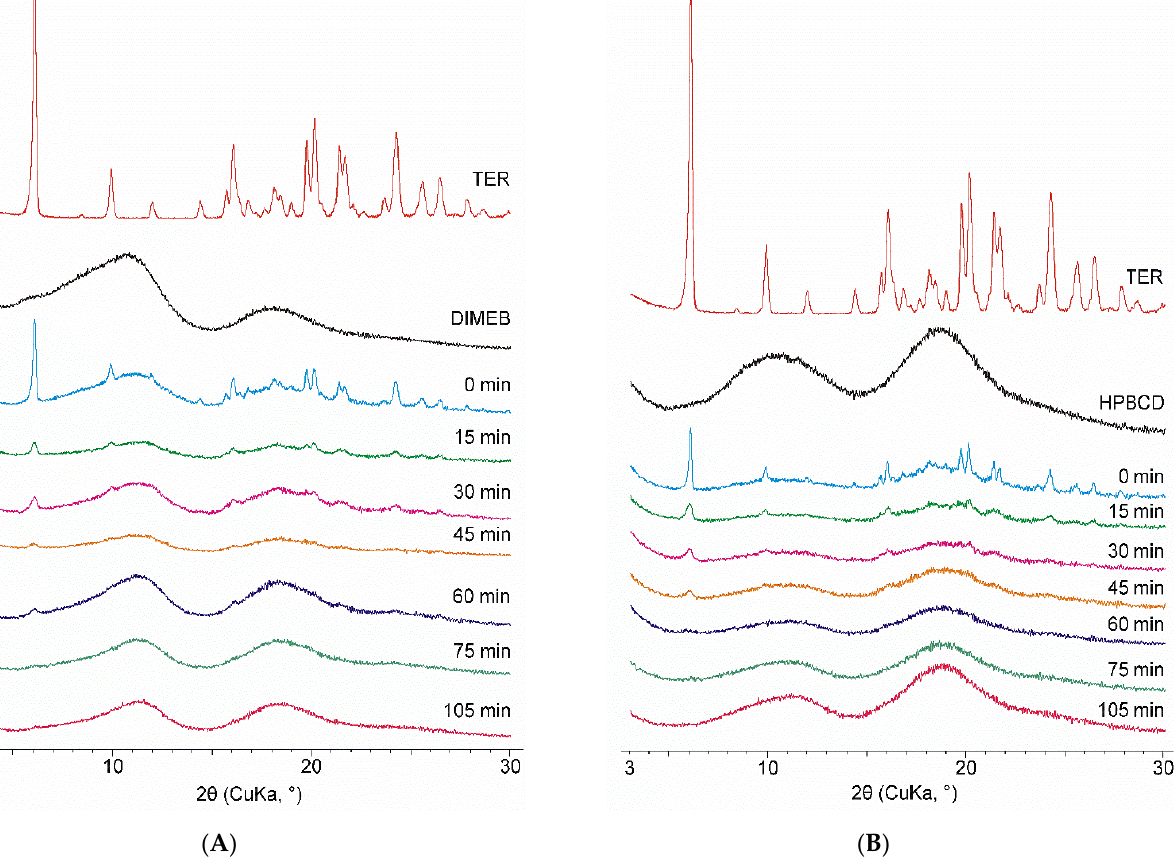
Figure 3. XRPD diffractograms of DIMEB ( A ) and HPBCD ( B ) samples taken during co-grinding (15 – 105 min) with starting materials and physical mixture (0 min).